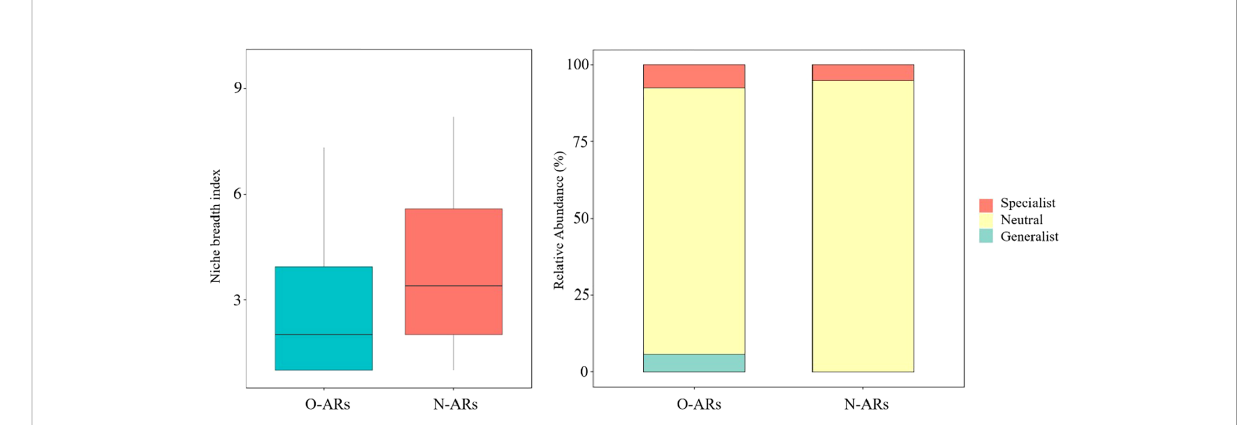
FIGURE 8 Coef fi cient of niche breadth (left) and species specialization (right). The area sizes of different colours in the right fi gure represent the relative abundance of different taxa (specialist species, generalist species and neutral taxa).